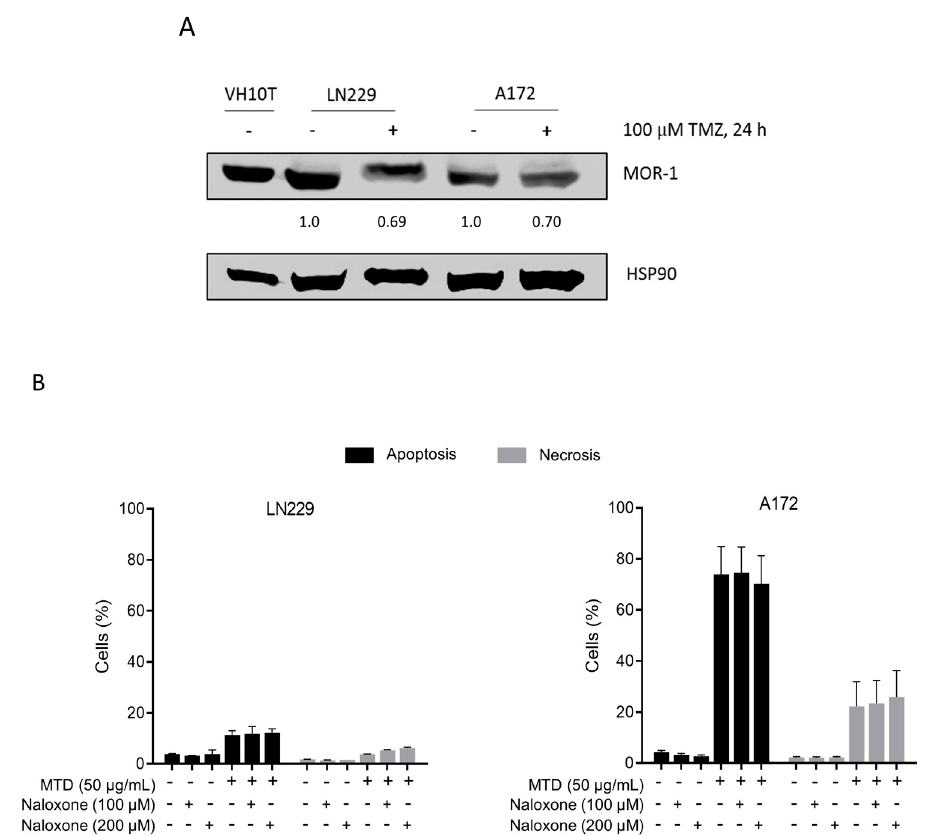
Figure 5. Expression of µ -opioid receptor MOR-1 in LN229 and A172 cells and e ff ect of naloxone. ( A ) For comparison the level in human diploid fibroblasts VH10T are shown. The e ff ect of TMZ on the receptor expression level was quantified in relation to the non-treated control, which was set to 1.0. ( B ) E ff ect of naloxone on MTD-induced cell death. Naloxone was administered 30 min before the addition of MTD to the medium. Data are the mean of three independent experiments.